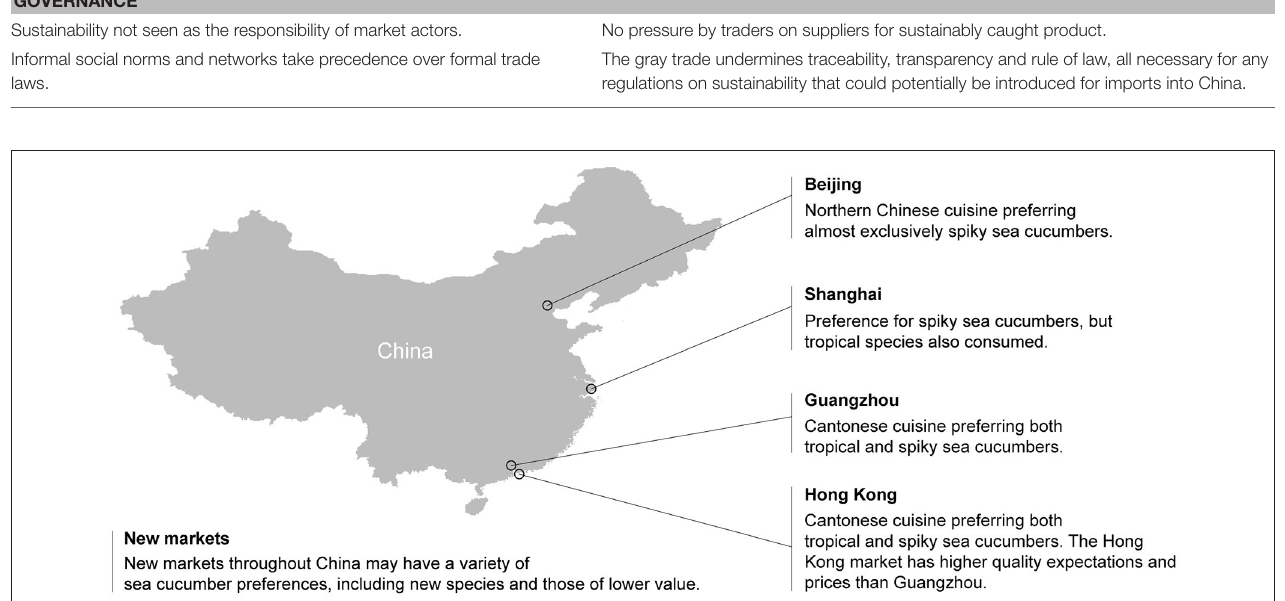
TABLE 2 | Summary of perceptions in China that influence BDM consumption and governance. Perception Environmental and socio-economic implications CONSUMPTION Banqueting culture provides impetus for luxury consumption. Social pressure to consume. Increasing middle class wanting to buy luxury foods. Increasing demand for sea cucumbers. Consumer preference for food perceived as healthy, driving everyday consumption. Sustainable fisheries not seen as an important quality of sea cucumbers as a product. Quality of processing and country of origin are important.